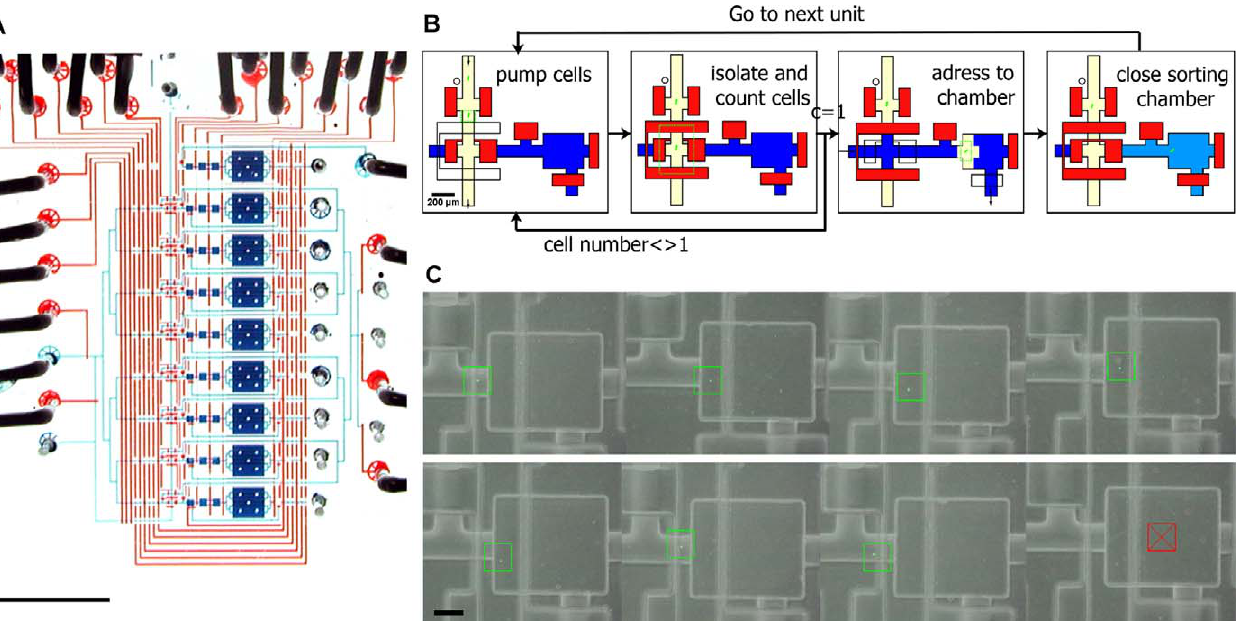
Figure 1. Photograph of a Single-Cell Isolation and Genome-Amplification Chip Capable of Processing Nine Samples in Parallel (Eight Cells, One Positive Control) (A) To visualize the architecture, the channels and chambers have been filled with blue food coloring and the control lines to actuate the valves have been filled with red food coloring (scale bar 5 mm). (B) Schematic diagram of the automated sorting procedure. Closed valves are shown in red, open valves are transparent (for a description see text body). Cells are drawn in green. (C) Typical result of cell sorting showing for each unit (seven with a single cell and one negative control without a cell) a color combination of a phase contrast image (gray) and a fluorescence image (green). A green overlaid square has been placed around the cell to ease visualization, whereas a red crossed square indicates the absence of cell. Scale bar is 100 l m.